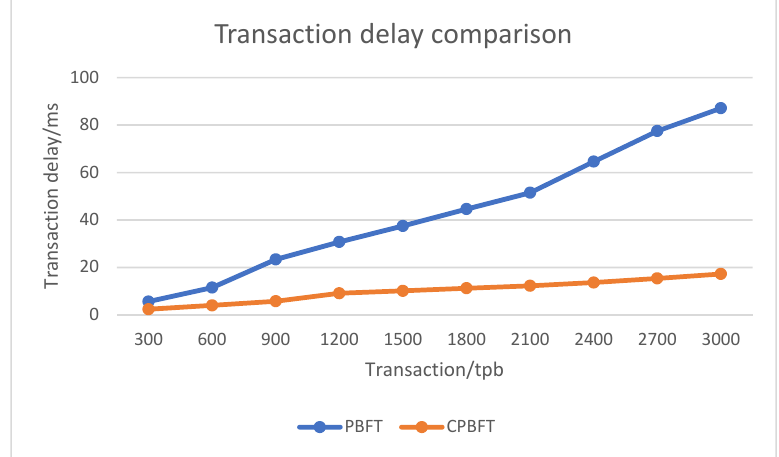
Figure 9. Comparison of CPBFT and PBFT transaction delay. Table 2. Performance comparison of consensus